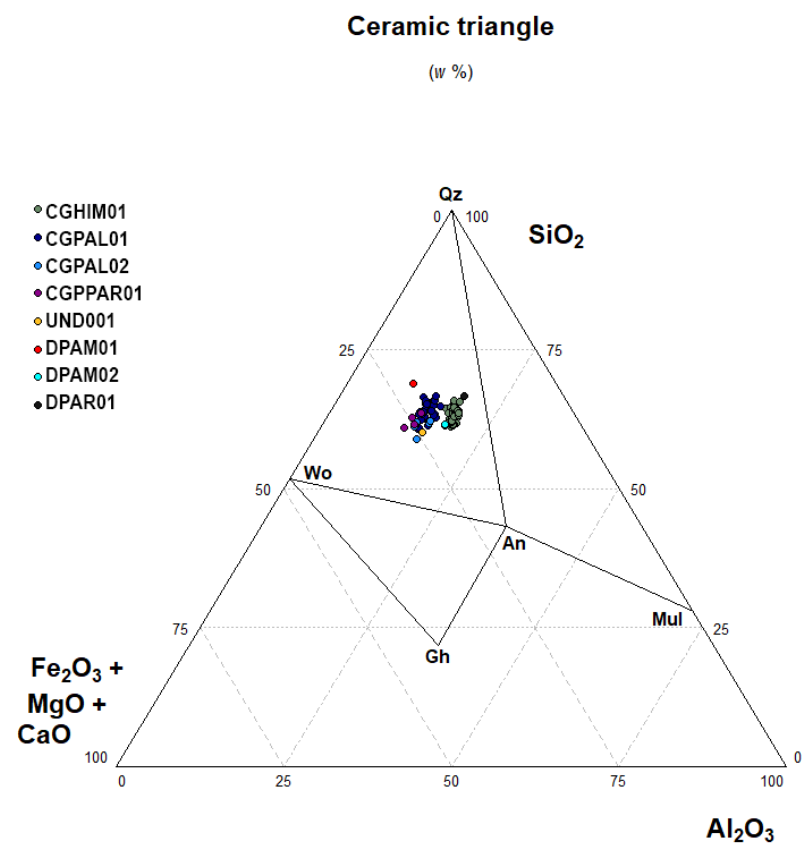
Figure 11. Ternary diagram of the system (CaO + Fe 2 O 3 + MgO)-Al 2 O 3 -SiO 2 . An: anorthite (Ca[Al 2 Si 2 O 8 ]); Gh: gehlenite (Ca2Al[AlSiO 7 ]); Mul: mullite (Al 6 [Si 2 O 13 ]); Qz: quartz (SiO 2 ); Wo: wollastonite (CaSiO 3 ) (abbreviations according to [96]).